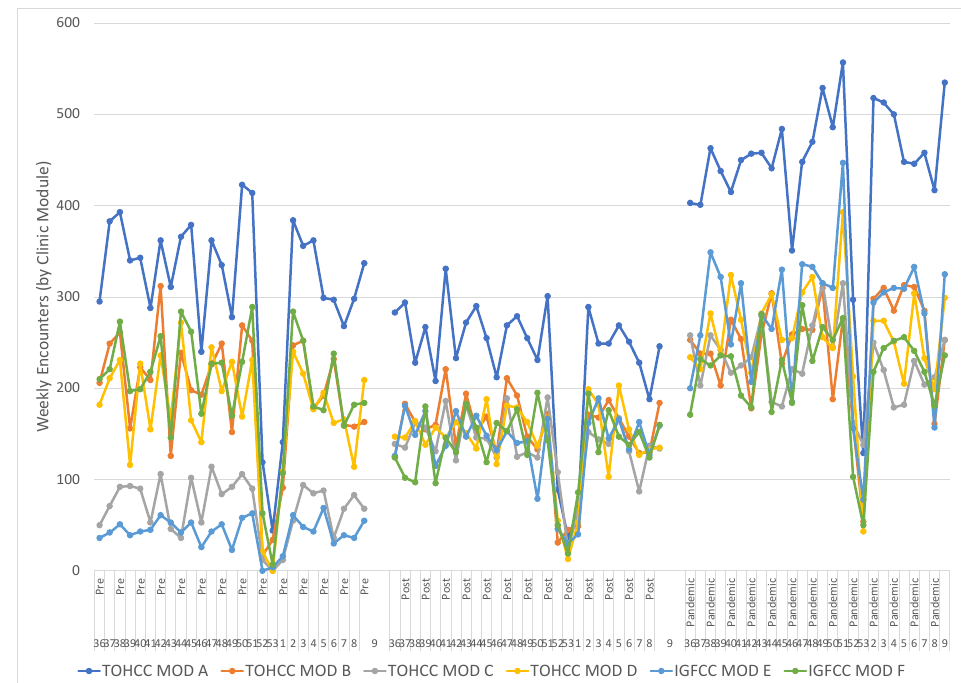
Figure 1. The total weekly activity in the six clinic modules during the three sample intervals (Pre, Post, Pandemic) became less variable and underutilization was reduced. The large activity disruption in each interval is the New Year period. Activity in Mod E was increased from 4% to 17% and in Mod C from 7% to 14% while the fraction in Mod B was reduced from 20% to 15%. Two chi-square tests of independence showed that there was a significant and sustained association between the schedule change and activity distribution in the modules, (Pre-Post X 2 (6, N = 25,293) = 4110, p < 0.0001, Pre-Pandemic X 2 (6, N = 43,431) = 8329, p < 0.0001).